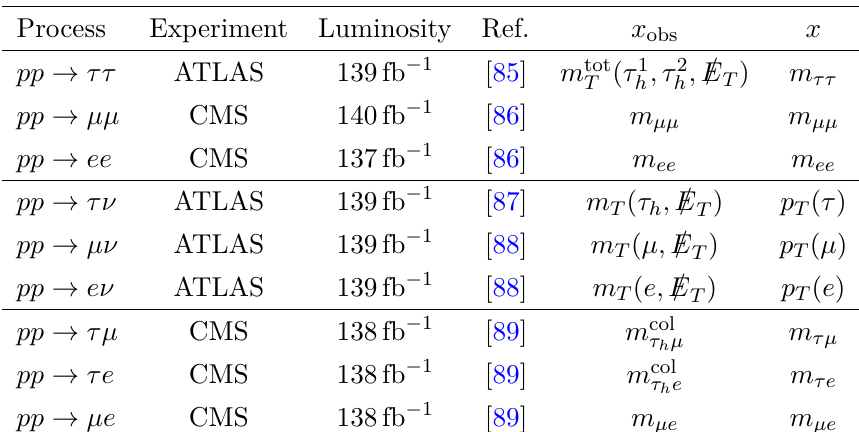
200 GeV, for obs ≥